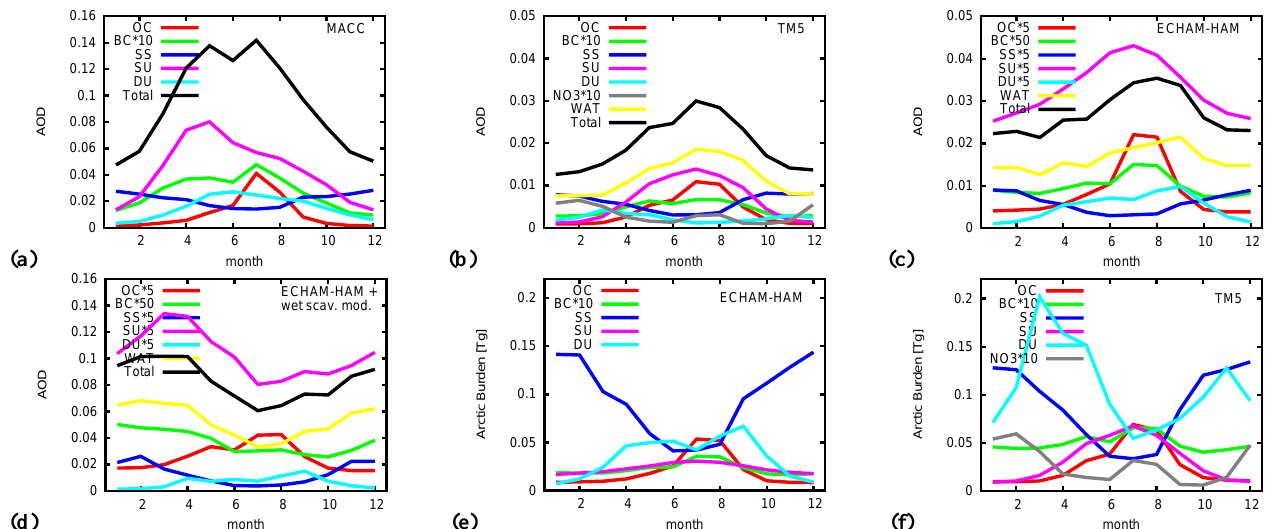
Fig. 9. (a) Averages over the Arctic (north of 60 ◦ N) of the contribution to total AOD of different compounds for the MACC reanalysis (these are ambient aerosol contributions, i.e. including water); (b) average AOD of different compunds in the TM5 model (ambient aerosols). (c) the same for the ECHAM-HAM (EIPCC) simulation (a direct comparison is not possible since diagnosed aerosol water is treated as a separate compound in HAM diagnostics and the dry aerosol contributions are shown); (d) the same as (c) for the ECHAM-HAM (EIPCC) simulation with the (Bourgeois and Bey, 2011) wet scavenging modification. (e) average total burdens (in Tg) over the Arctic for the ECHAM-HAM (EIPCC) simulation. (f) average total burdens (in Tg) over the Arctic for the TM5 simulation. A factor 1.4 has been used to convert particulate organic matter to organic carbon for TM5. MACC data are averaged over the years 2003–2006. TM5 and ECHAM-HAM data are averaged over the years 2001–2006. AOD and burdens of black carbon have been multiplied by 10 for clarity in all panels. An additional factor of 5 has been applied to show the seasonalities of dry AOD contributions of individual compounds for ECHAM-HAM in panels (c) and (d)